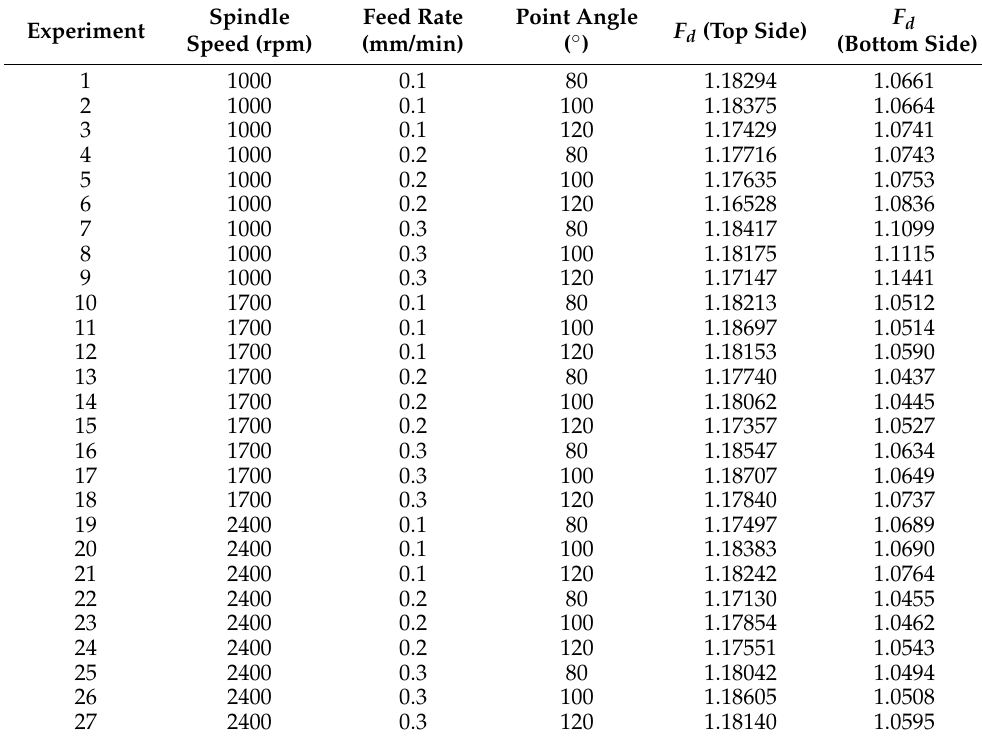
Table 2. Experimental results indicating delamination at various spindle speeds, feed rates and point